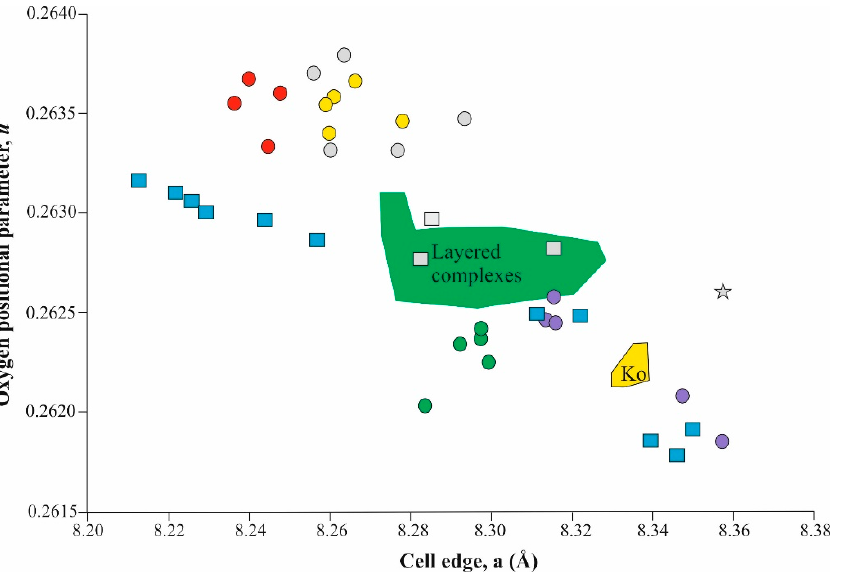
Figure 4. Oxygen positional parameter, u , versus cell edge, a. Black circles: Cr-spinels from Sit- tampundi (this study); red circles: detrital Cr-spinels from Banavara [66]; grey circles, squares and star: Cr-spinels from Amsaga (Mauritania) in amphibole, chlorite and talc-serpentine matrix, respec- tively [34]; yellow, purple and green circles: Cr-spinels from Fiskenaesset and Ujragassuit (Greenland) and Zimbabwe, respectively [35]; blue squares: Cr-spinels from Rum (Scotland) [32]; green field: Cr-spinels from Bushveld and Stillwater complexes [31,33]; yellow field: Cr-spinels from Nuggihalli komatiites